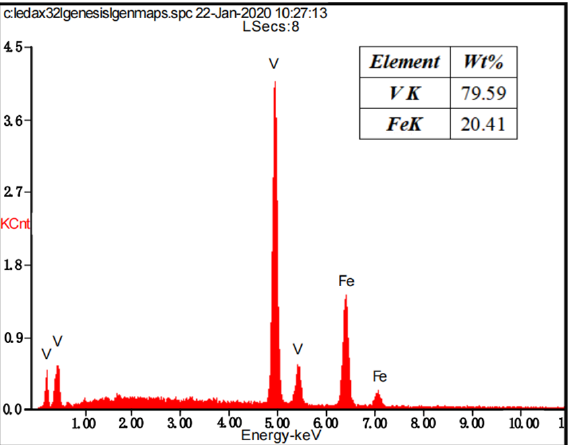
Figure 14. EDS spectrum of deposited layer surface under optimum conditions.